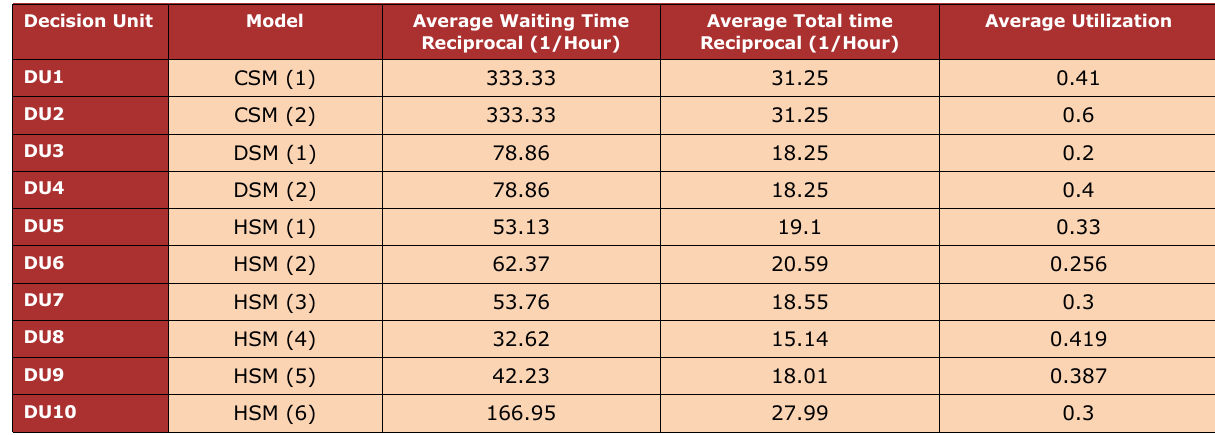
Table 11. DEA outputs for the setting with medium interaction